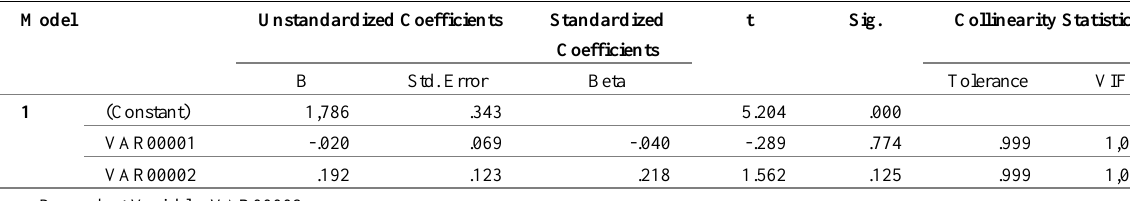
Table 5: Multicollinearity Test Results